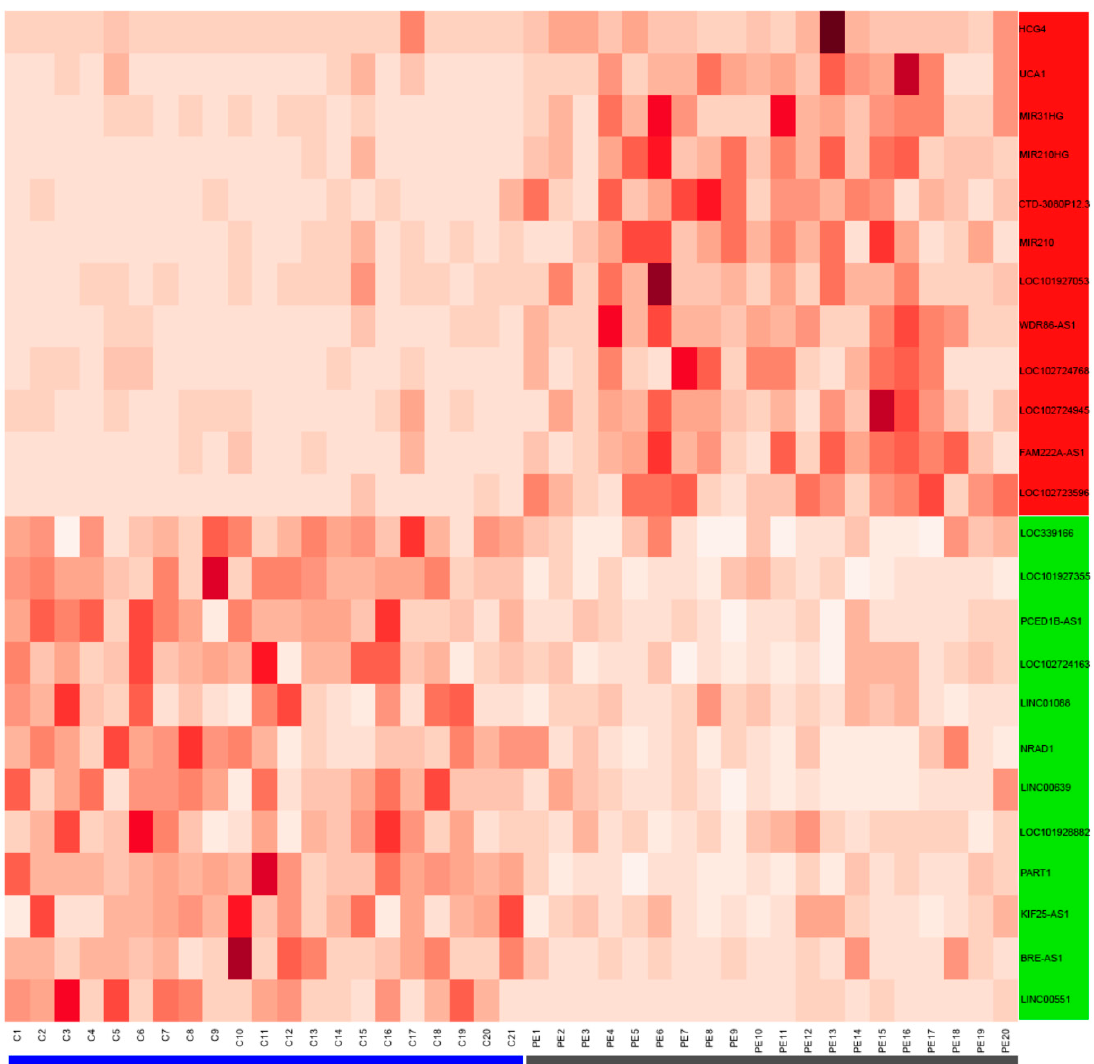
Figure 2. Differentially expressed genes in preeclampsia samples compared with normal pregnancy controls. Heatmap of the top 12 up- or downregulated ncRNAs. The red rectangle indicates upreg- ulated ncRNAs and the green rectangle represent downregulated ncRNAs. Horizontal rectangles denote control (blue) and PE (gray) samples. The normalized counts are represented in the heatmap.